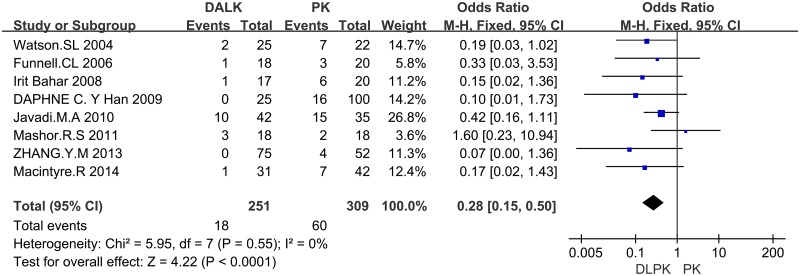
Forest plot comparing the rate of graft rejection between DALK and PK.CI = confidence interval; SD = standard deviation; DALK = deep anterior lamellar keratoplasty; PK = penetrating keratoplasty.